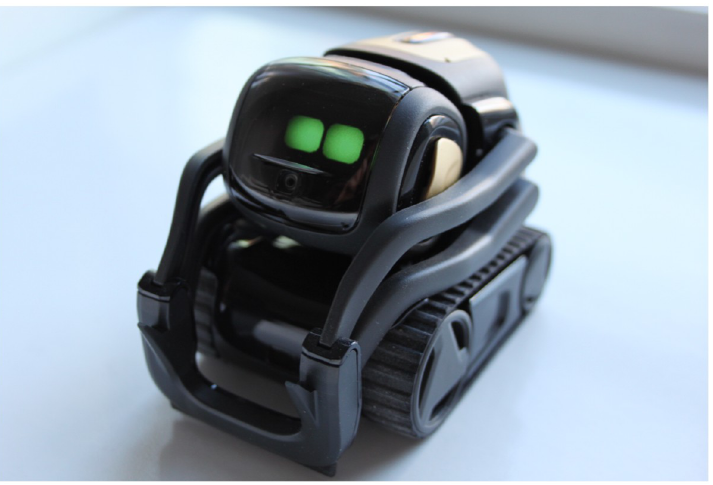
Fig 1. Vector the robot. Vector behaves as a result of network spiking